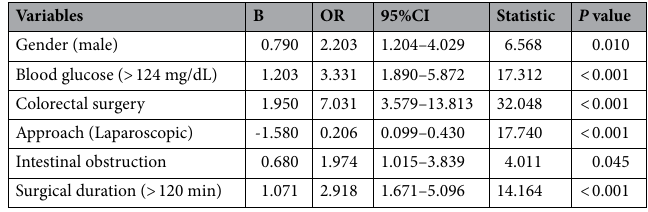
Table 5. Results of multivariate logistic regression